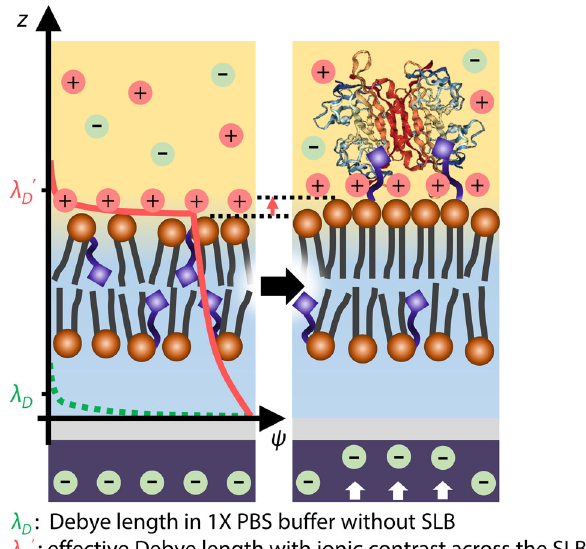
Fig. 5 Improved molecular detection via asymmetric ionic environment across the SLB. Schematic illustration of effective Debye length ( λ D ′ ) with ionic contrast across the SLB and conformational change upon avidin